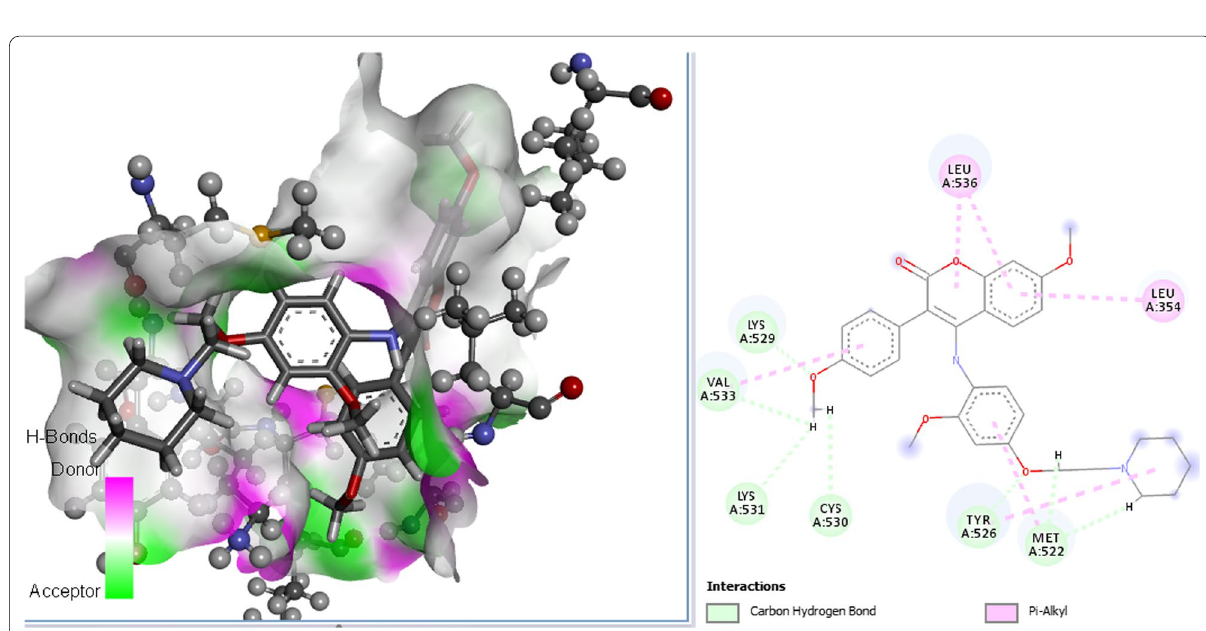
Fig. 11 3D and 2D interactions of designed compound 6 with the active site of the ER +